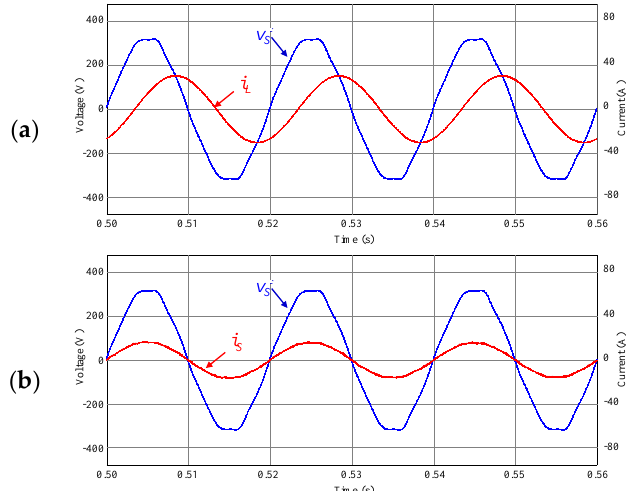
Figure 10. Steady-state analysis of the SAPF operation with linear Resistive-Inductive (RL) Load: ( a ) Source voltage and load current; ( b ) Source voltage and source current.